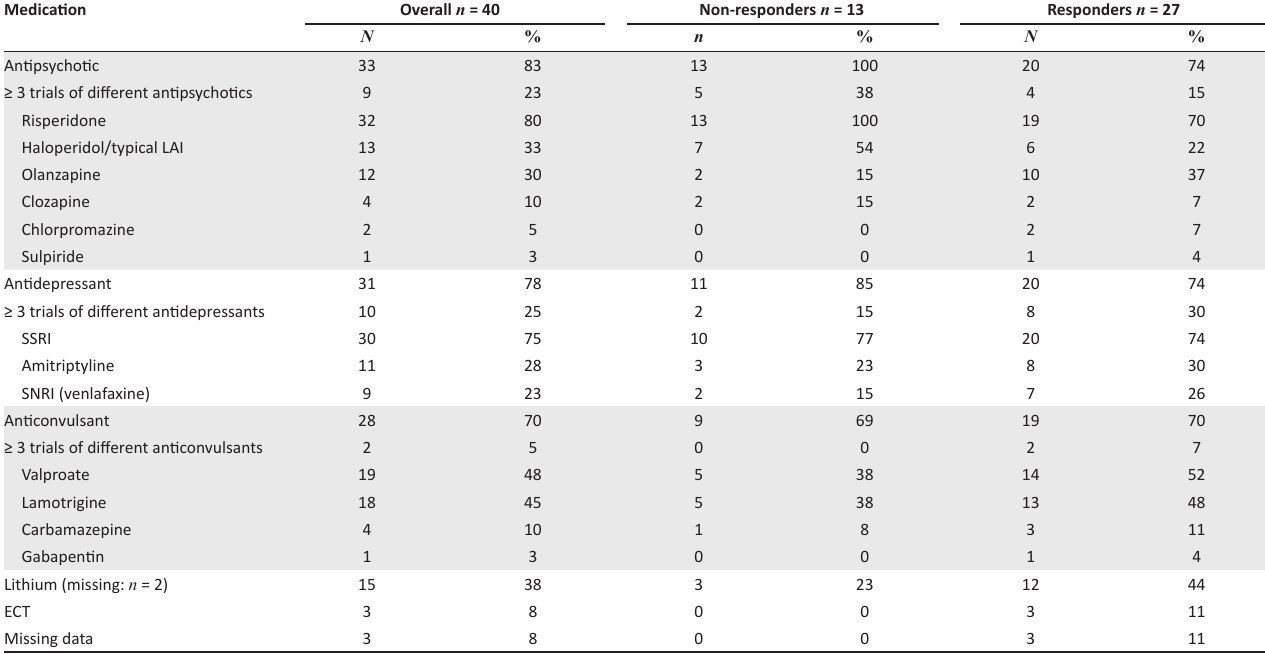
TABLE 3: Percentage of patients who had received previous medication trials. Medication